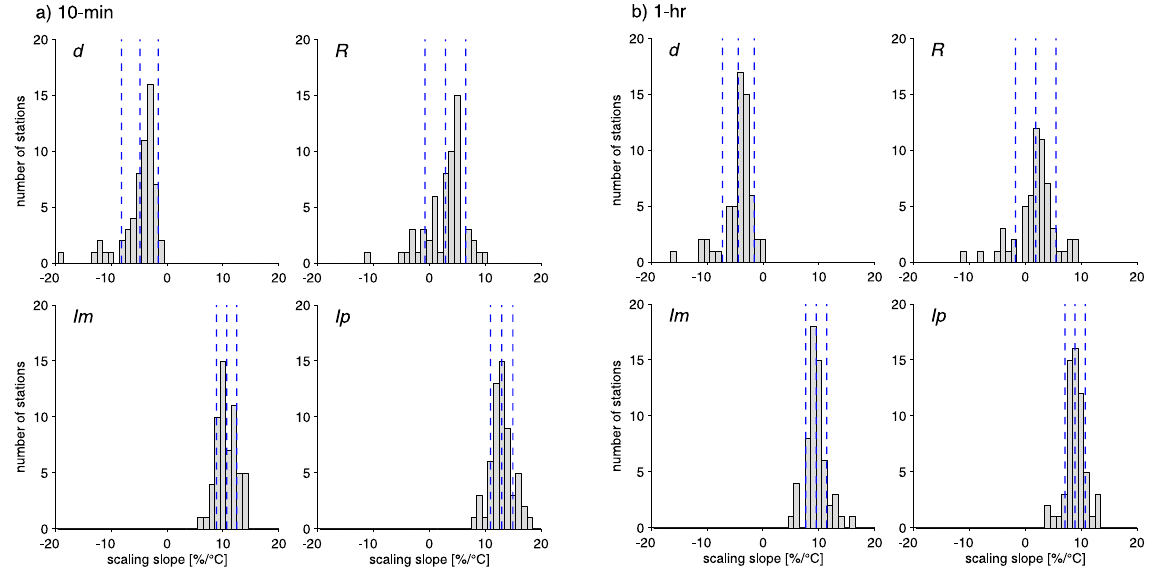
Figure 2. Histograms of the scaling slopes in % ◦ C − 1 fitted to the 95th percentiles of event duration d , total storm depth R , mean intensity I m and peak intensity I p for 59 stations computed with the quantile regression method. Data are shown for (a) 10min and (b) 1h resolutions. Vertical dashed lines indicate the mean ± 1 standard deviation. The same figure for the temperature binning method is in the Supplement. Table 1. Means of the regression slopes in % ◦ C − 1 fitted to the 95th percentiles by quantile regression ± 1 standard deviation. Slopes are reported for mean I m event intensity for 10min and 1h time resolutions for all events, no-lightning events, lightning events, and storms grouped by the convectivity index β